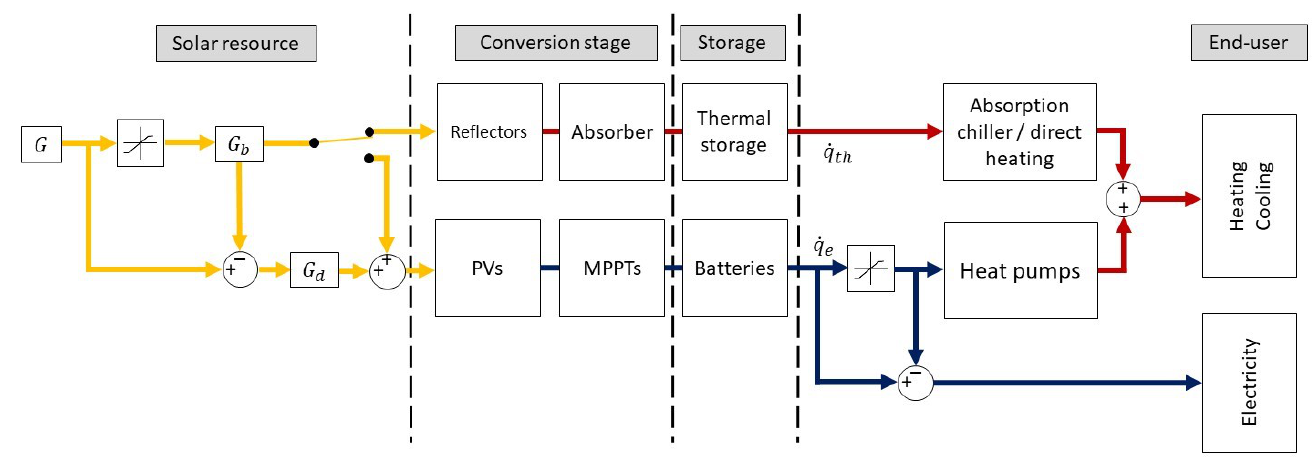
Figure 3. Hybrid collector